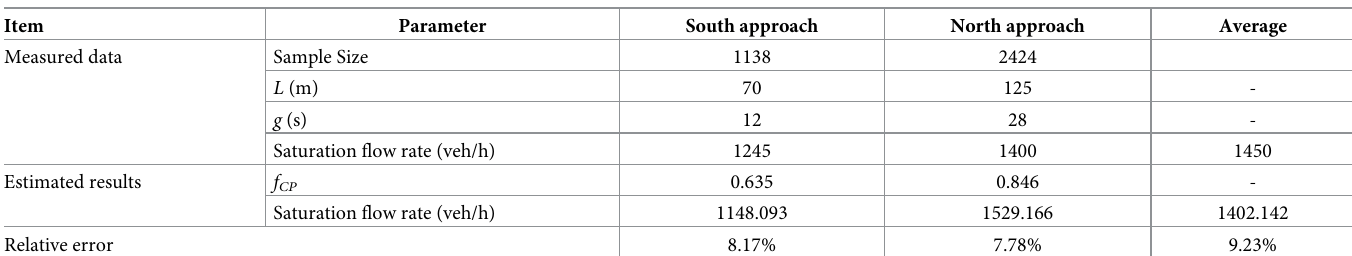
Table 10. Validation for left-turn at the pre-signal of CFI